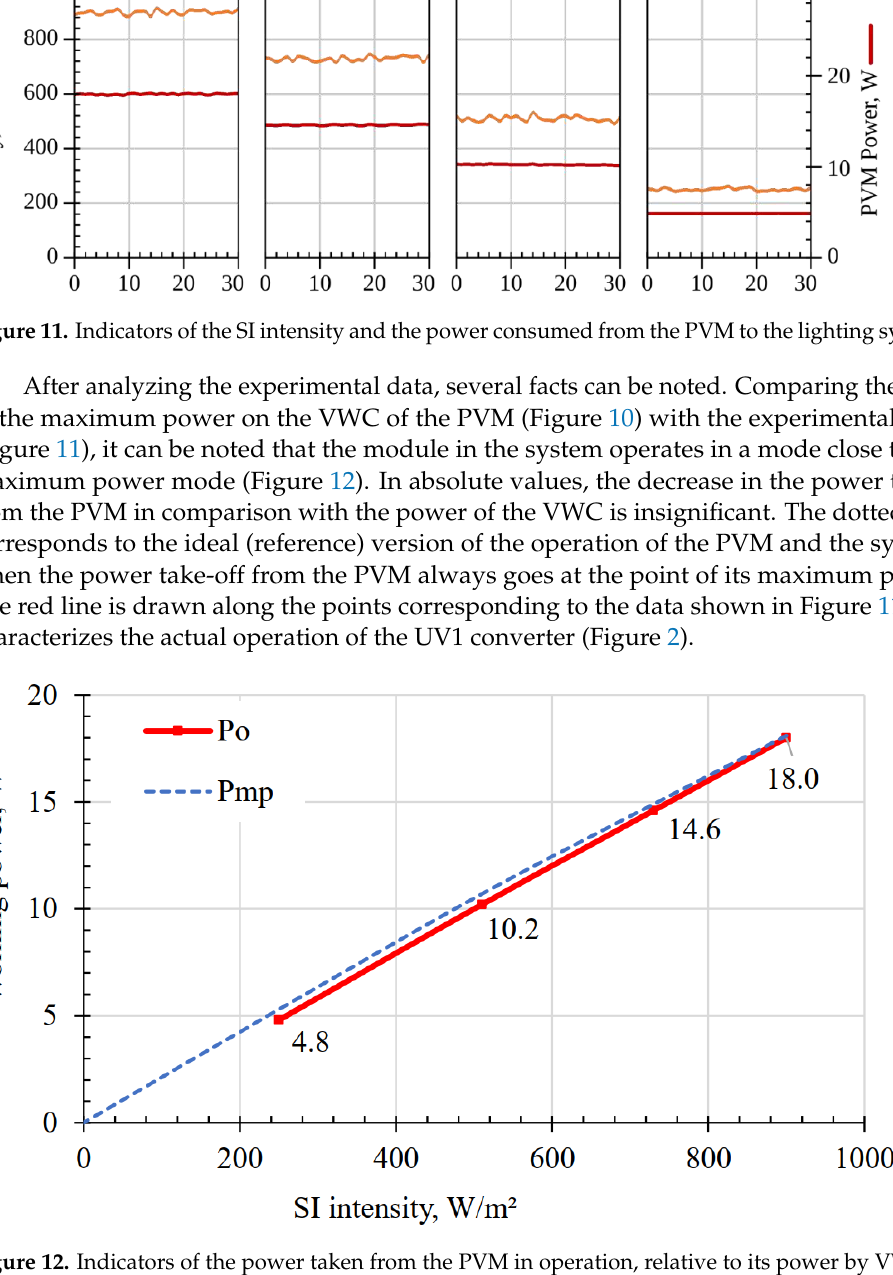
9 of 13 Figure 10. VWC of the photovoltaic module at different solar radiation intensities: (R900) at an average intensity of 900 W/m 2 ; (R730) at 730 W/m 2 ; (R510) at 510 W/m 2 ; (R250) at 250 W/m 2 . As can be seen from the figure, the maximum power of the module was about 18 W at an SI intensity of 900 W/m 2 . Immediately after taking the characteristics, the module was connected directly to the lighting system according to the scheme shown in Figure 2.